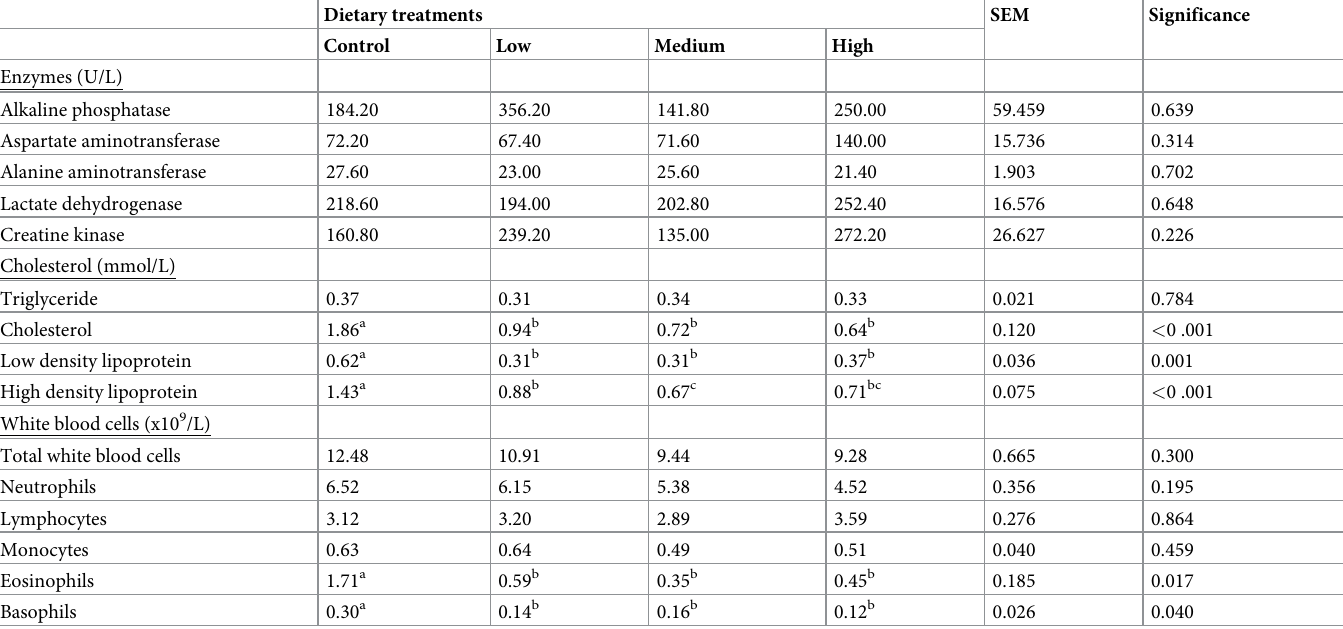
Table 9. Effects of increasing levels of lovastatin on blood biochemistry and hematology. Dietary